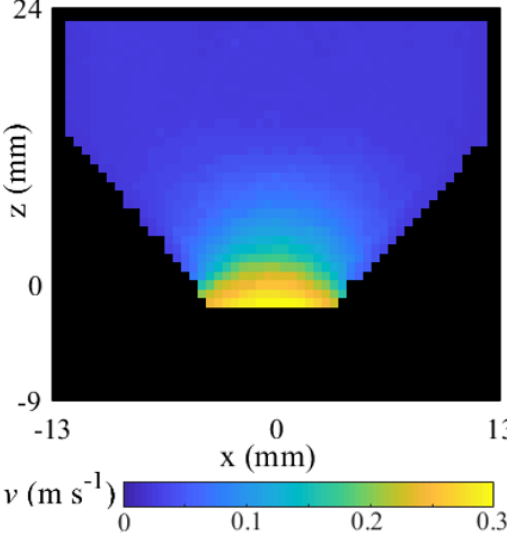
Fig. 6. The vertical 2D map of the vertical velocity.